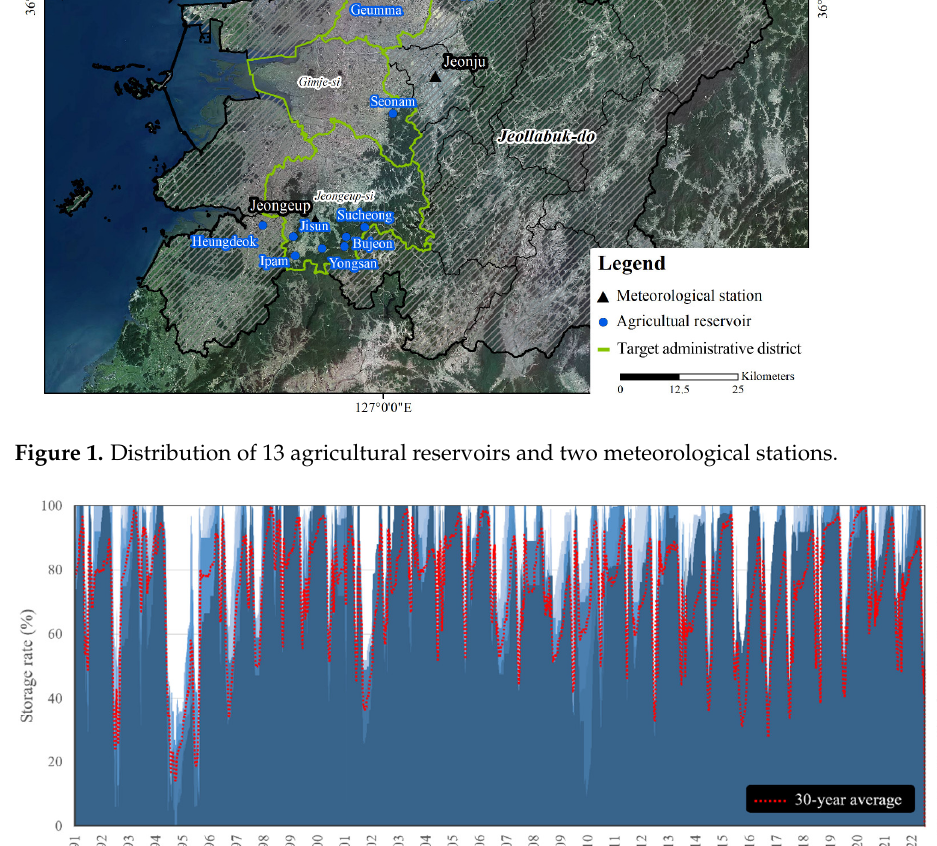
Figure 1. Distribution of 13 agricultural reservoirs and two meteorological stations.